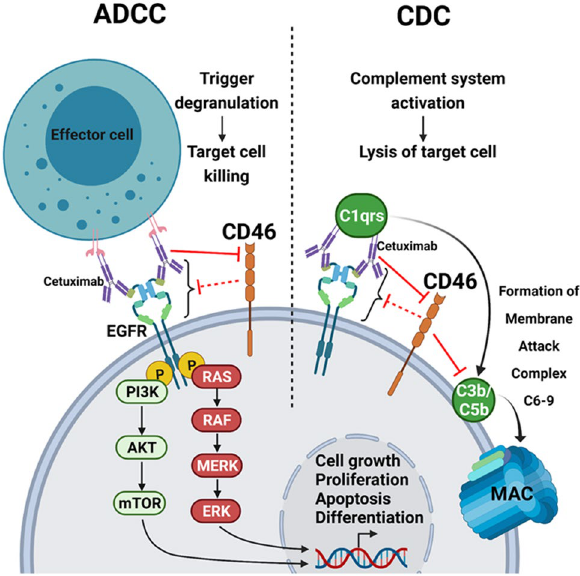
Figure 5. Schematic model of action mechanism of CD46 in the process of ADCC and CDC. ADCC occurs when the extracellular domain of the EGFR of target cell membrane is bound by the Fc region of cetuximab, blocking ligand binding, receptor dimerization, and intracellular signaling; this results in the lysis of the target cells via the production of cytokines and release of cytotoxic compounds. Natural killer (NK) cells are the typical ADCC effector cells. The complement system is also involved in modulating the anti-tumor activity of cetuximab. The Fc portion of cetuximab activates the complement C1 complex subsequently to form C3b and C5b deposited on the target cell surface, which leads to the formation of terminal complex called the MAC to lyse the cells. CD46 protects the host cells from CDC by binding to C3b, inactivating C3b and C4b, and preventing subsequent degradation by the plasma serine protease. Cetuximab ultimately induces cell death via both CDC and ADCC mechanisms. In this model, we propose that the cytotoxic effect of cetuximab is mediated by both ADCC and CDC mechanisms as well as via the downregulation of CD46 expression. Solid red lines denote CD46 downregulation by cetuximab as demonstrated in this study. Dotted red lines suggest unknown mechanism of protective role of cetuximab mediated indirect effects as well as direct effects through the regulation of ADCC and CDC. “Created with